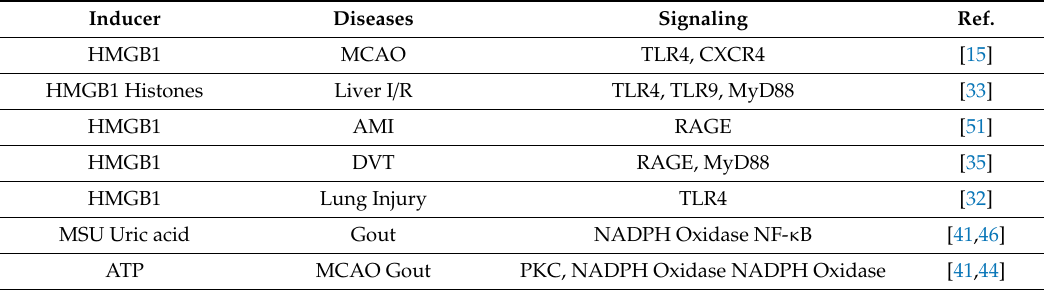
Table 1. Damage-associated molecular patterns (DAMPs) inducing NETosis in non-infectious disease. Inducer Diseases Signaling Ref. HMGB1 MCAO TLR4,